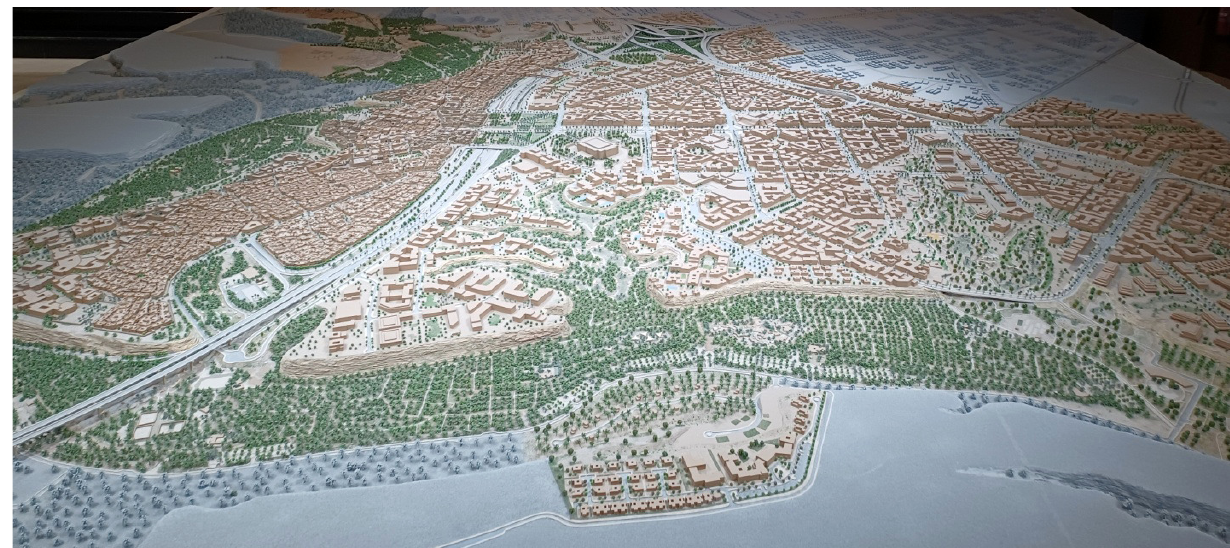
Figure 1. At‐Turaif District in Al Diriyah, Riyadh: Physical model of the urban regeneration project and the new phases of development in the Diriyah Gate Development Authority main